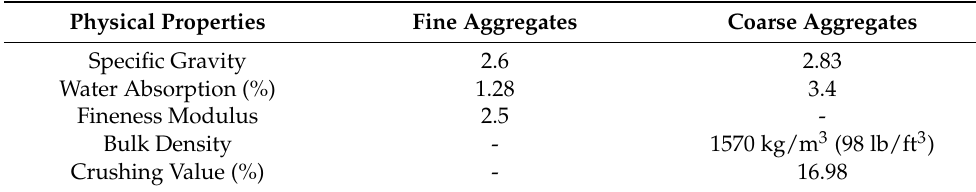
Table 2. Physical properties of coarse and fine aggregates.